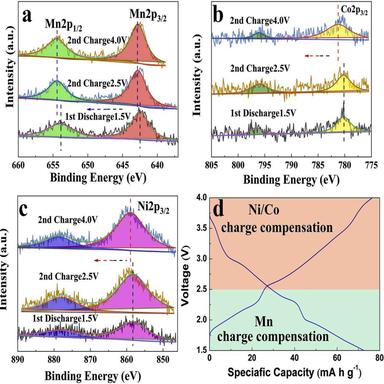
Ex situ XPS spectra of the (a) Mn2p, (b) Co2p and (c) Ni2p for pristine electrodes collected at different charge states. (d) Different elements' charge compensation contribution for capacity during different voltage range.